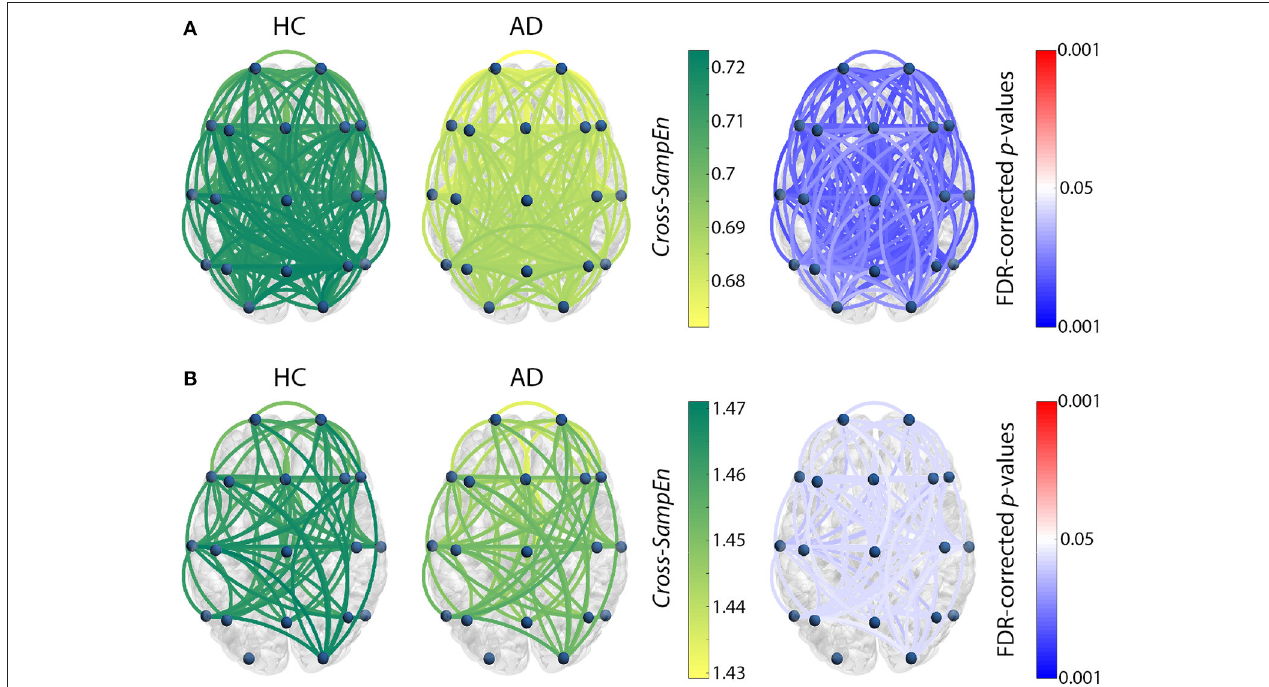
FIGURE 2 | Cross-SampEn results for HC vs. AD comparison (A) at θ band, and (B) at β 1 band. Left and central columns depict Cross-SampEn values for controls and AD patients, respectively. Right column displays statistical results, where connections were only displayed when statistically significant differences were obtained (FDR-corrected p -values < 0.05, Mann-Whitney U -test). Red color tones indicate significant Cross-SampEn increases in AD compared with controls, whereas blue color tones denote significant